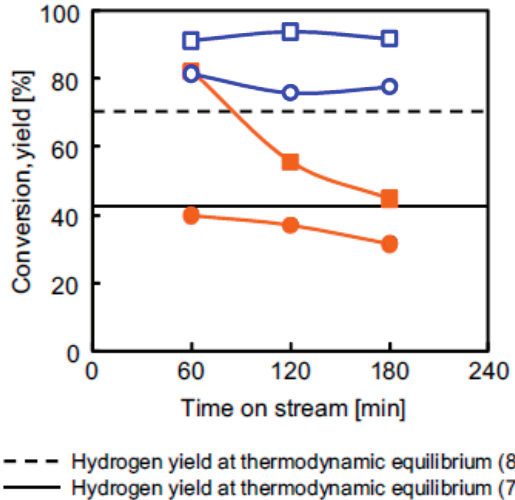
Figure 25. Conversion to C1 products and hydrogen yield at 773 K. Open symbols represent with pre-reforming and closed symbols represent without pre-reforming. Squares represent conversion to C1 and circles represent hydrogen yield